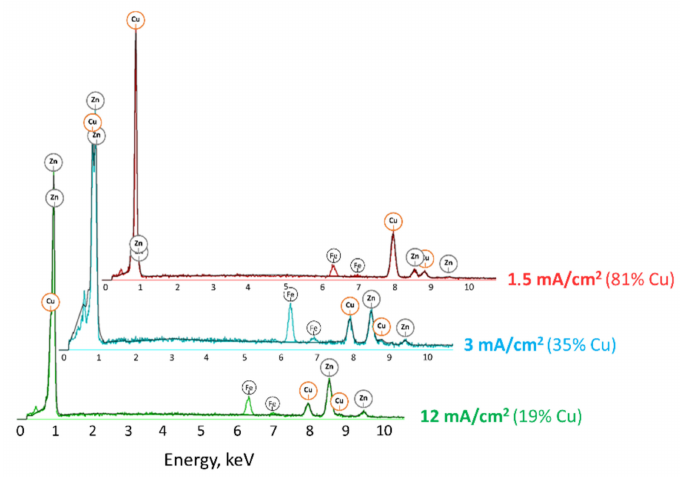
Figure 8. The EDX spectra of the brass coatings electrodeposited in the CuZn-4 bath (T = 100 ◦